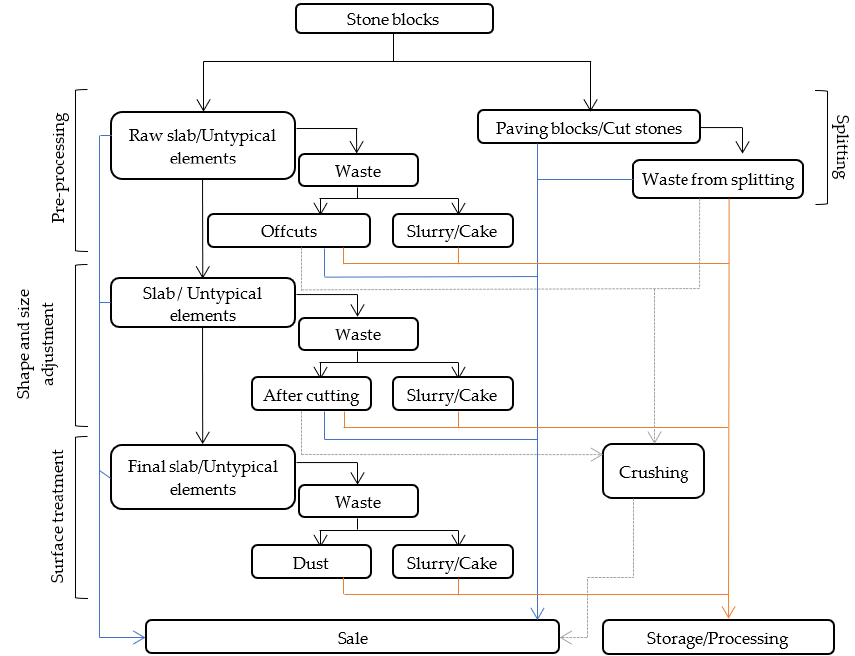
Figure 2. General diagram representing waste production in the processing of natural stone.